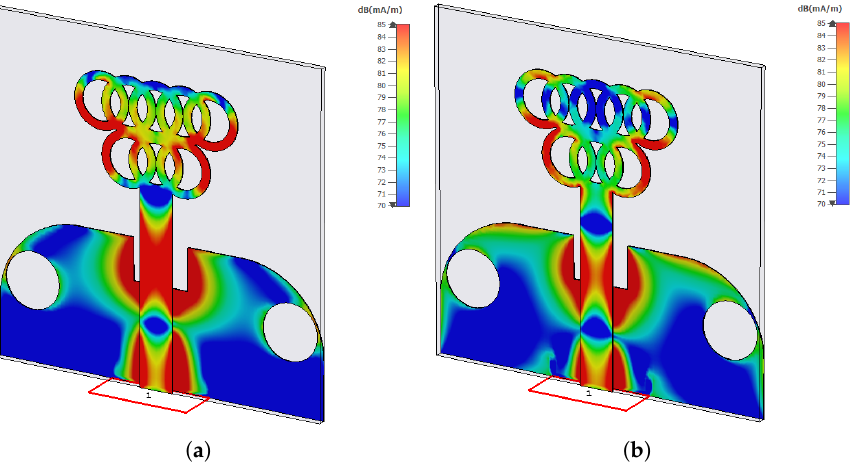
Figure 3. Surface currents of the olympeak antenna at a resonance frequency of ( a ) 28 GHz ( b ) 38 GHz. The effect of the ground plane notch etched at the top mid-section of the copper ground plane is given in Figure 4. The ground slot played an important role in shifting the resonance response to desired frequency. At 1.8 mm slot width, the maximum resonance was noted at 27.5 GHz which at 1.9 mm resulted in a very sharp dip, hence giving a reflection co-efficient value of − 45 dB at the same frequency. With a further gradual increase of 0.1 mm, the optimum response was noted at 2 mm. Further increasing the value resulted in a diminishing resonance response.